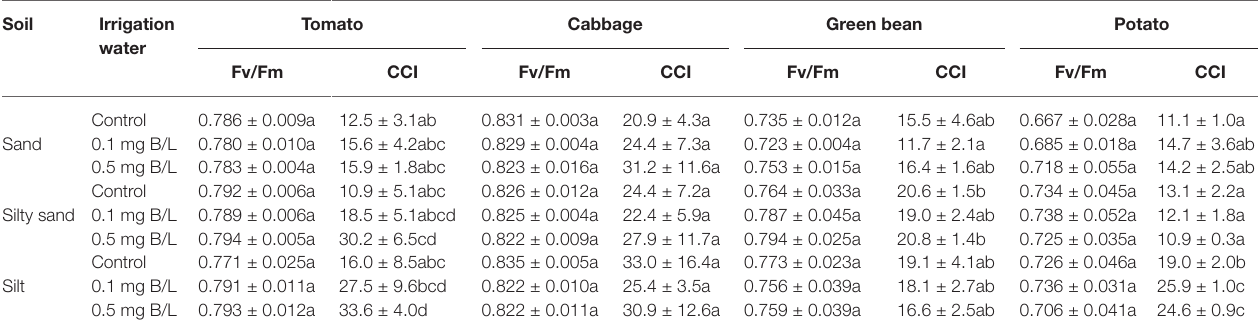
TABLE 4 | Chlorophyll content index (CCI) and quantum efficiency of PSII photochemistry (Fv/Fm) of investigated plants. Soil Irrigation Tomato water